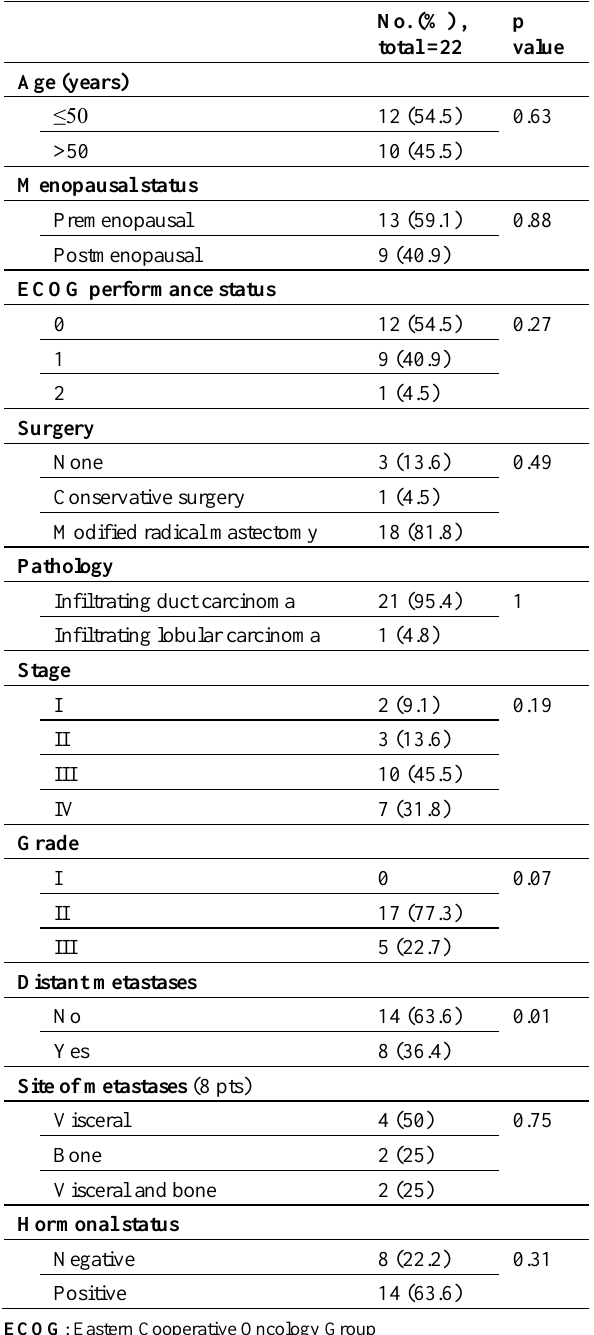
Table 4: Features of patients with high serum neopterin